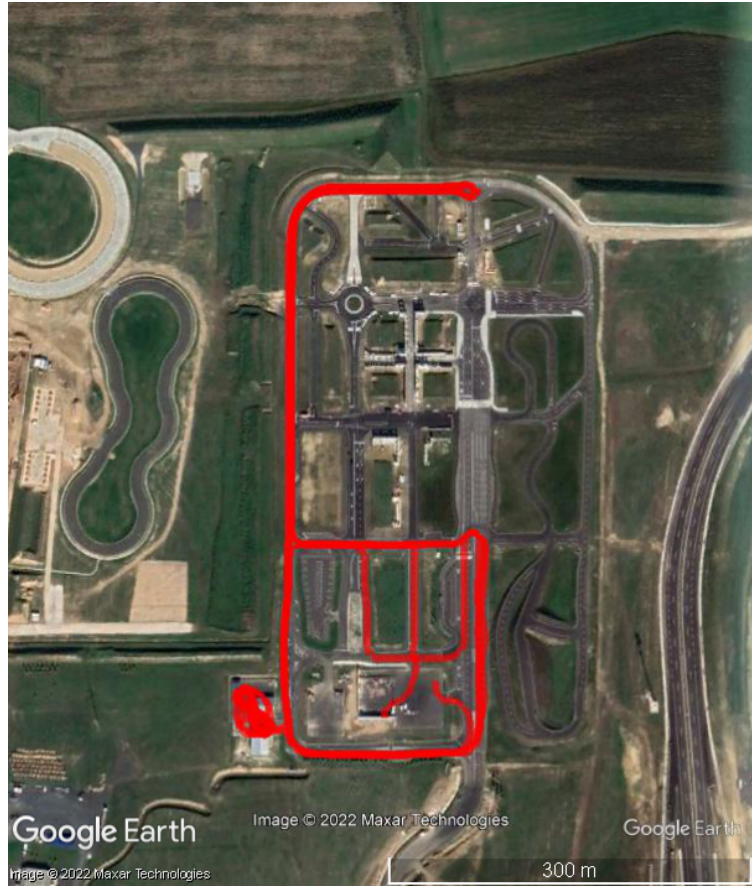
Figure 5. Trajectory of Case Study